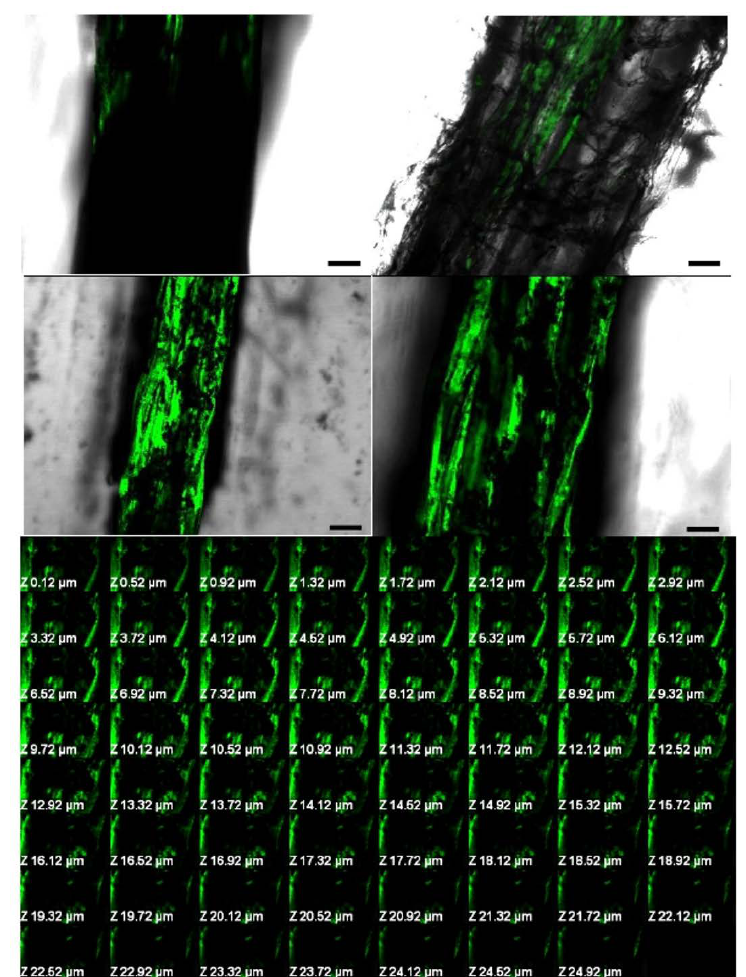
Fig. 4. Confocal microscopy images of MW3 and MW4 biofilm grown on Triticum aestivum root surface. (a) Colonization and biofilm formation by MW3 (moderate biofilm former). (b) Longitudinal section of primary root showing the aggregation of cells as biofilm formed by MW3. (c) Longitudinal section of primary root showing aggregation, colonization and strong biofilm formation on the root surface by MW4 (strong biofilm former). (d) Magnified image of figure 4c. Biofilms were stained with acridine orange. Magnification is 20x. Scale bars = 50 µm. (e) Confocal laser scanning micrographs of Z-stack analysis of Pseudomonas fluorescens (MW4) biofilm formed on Triticum aestivum seedling roots after 15 days of